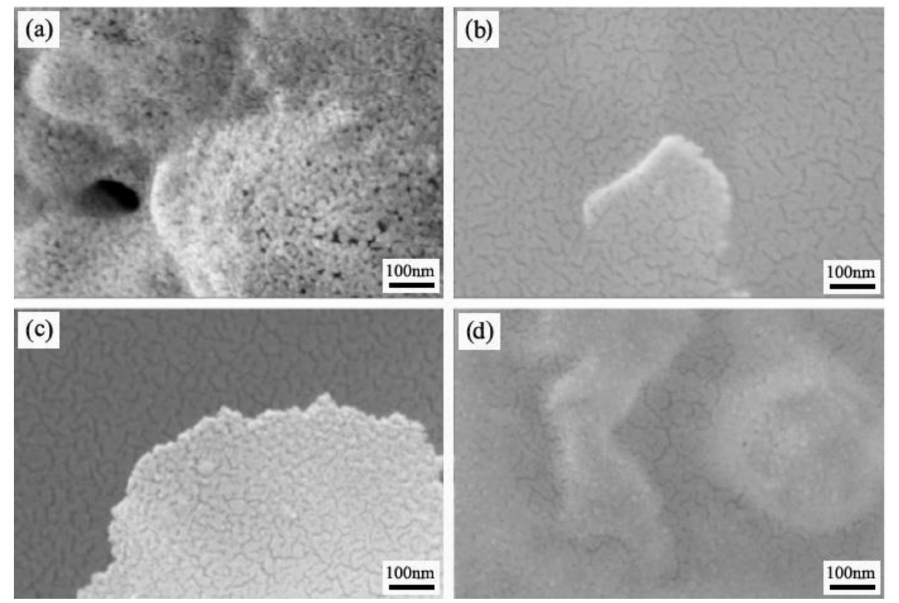
Figure 5. SEM images of the CeO 2 products prepared at various spray pyrolysis temperatures ( a ) 500 ◦ C; ( b ) 650 ◦ C; ( c ) 750 ◦ C; ( d ) 850 ◦